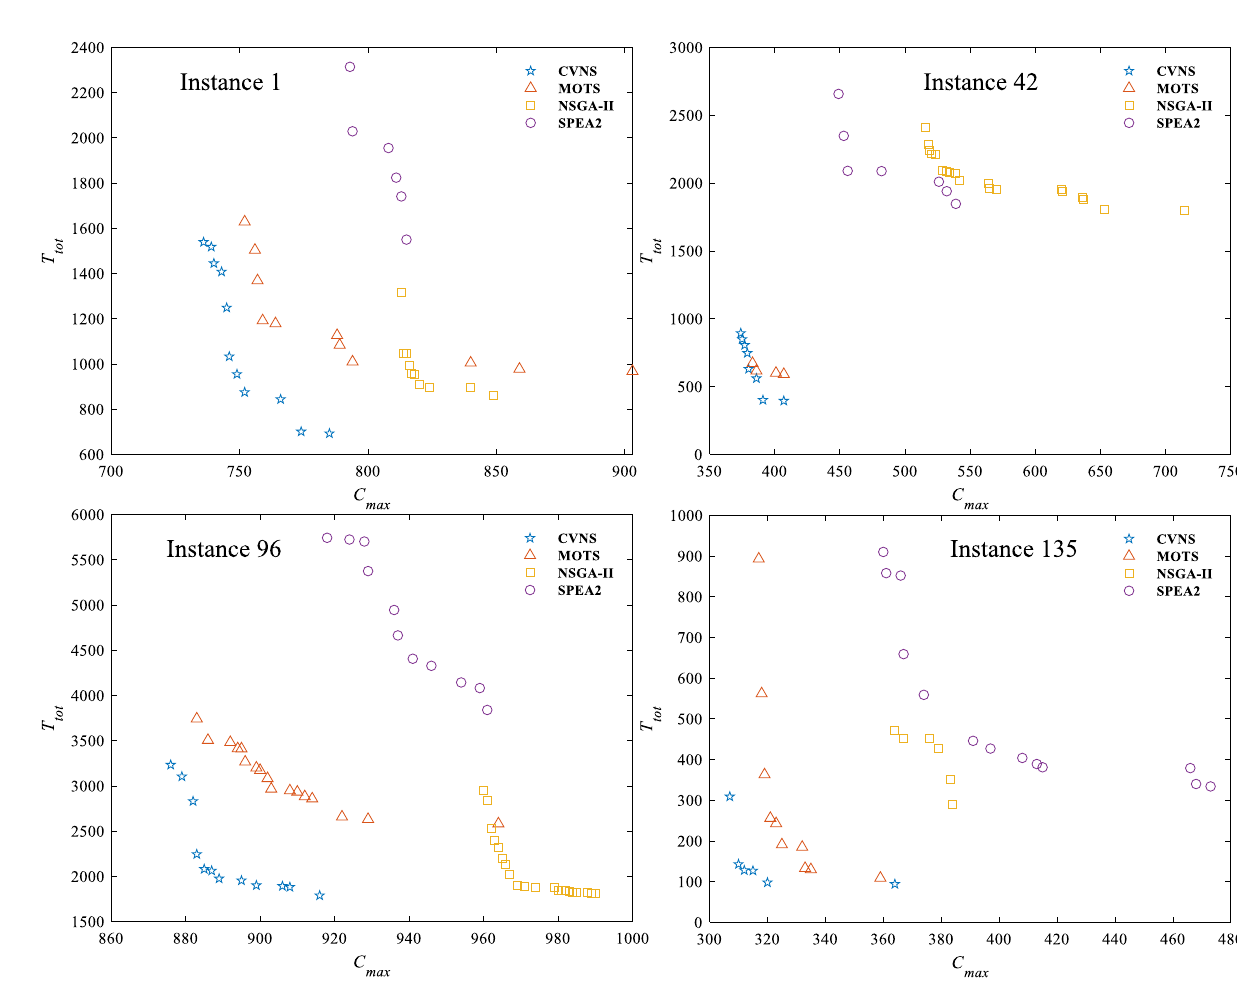
Figure 4. Distribution of non-dominated solutions of three algorithms.